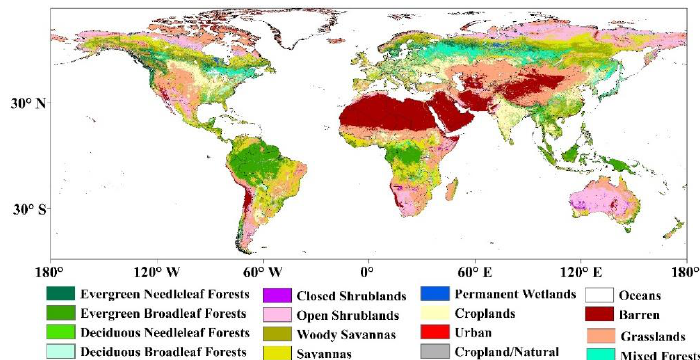
Figure 2. The global map of the MODIS land cover.